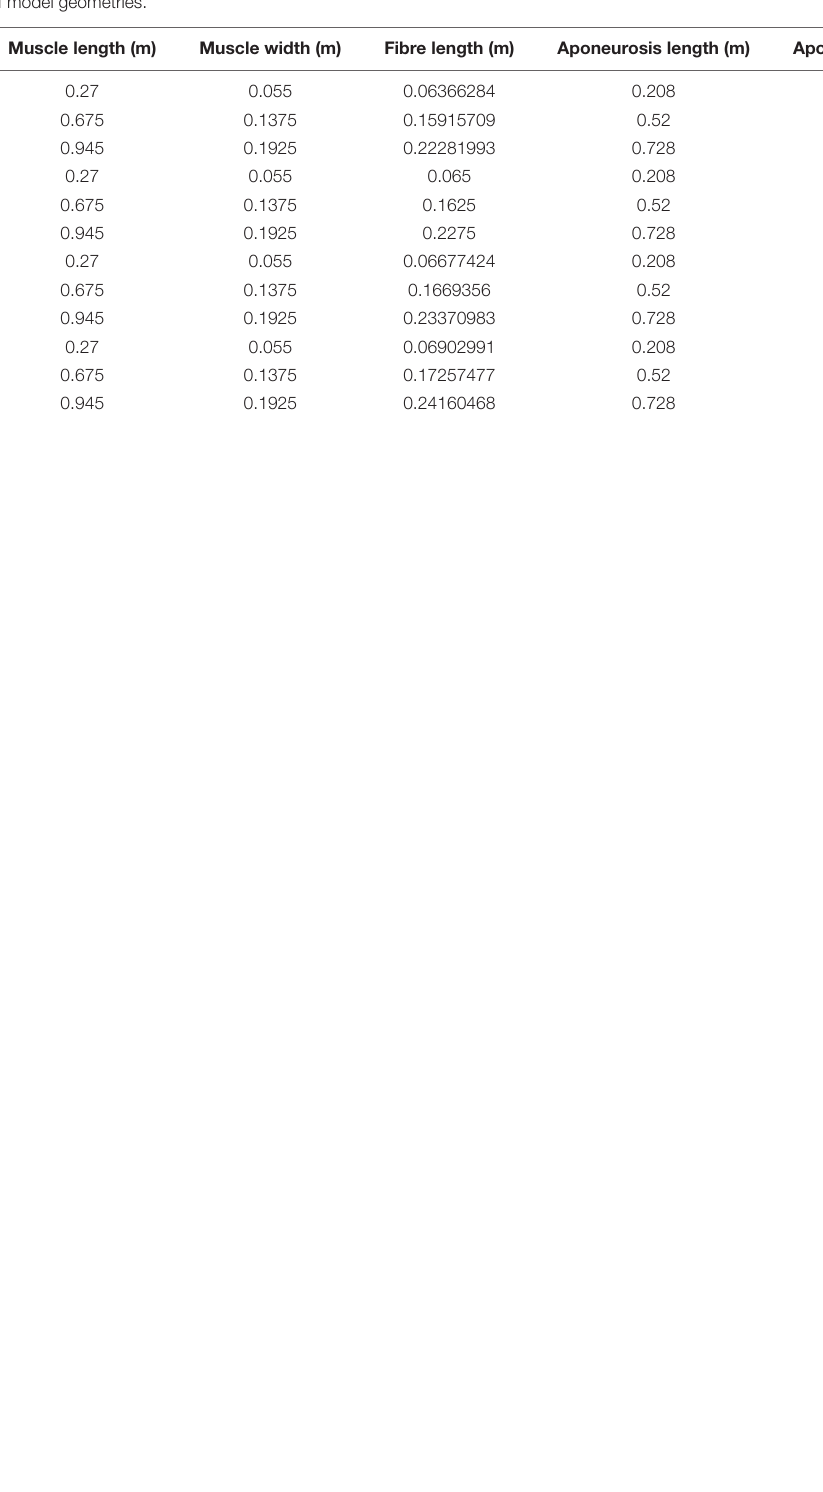
TABLE TA1 | Initial dimensions of model